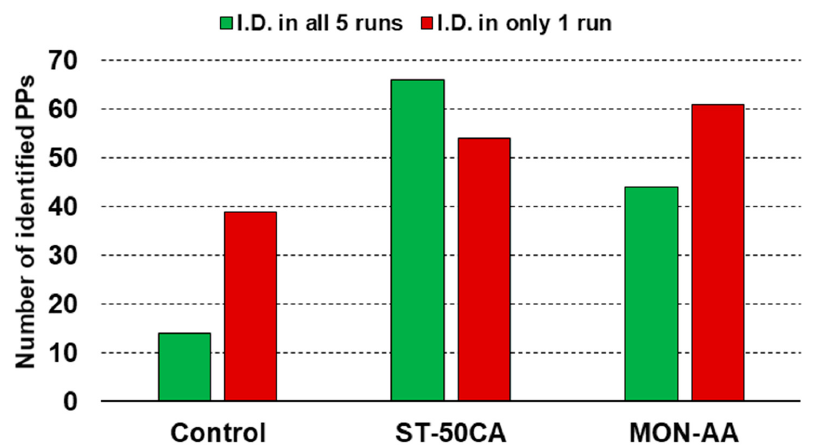
Figure 4. Qualitative (identification) repeatability of the Control, the ST-50CA method, and the MON- AA method. For each method, 5 parallel enrichments were performed. MON-AA method. For each method, 5 parallel enrichments were performed. Table 3. Relative standard deviations of model PP peak areas, calculated based on the results of five parallel enrichments.